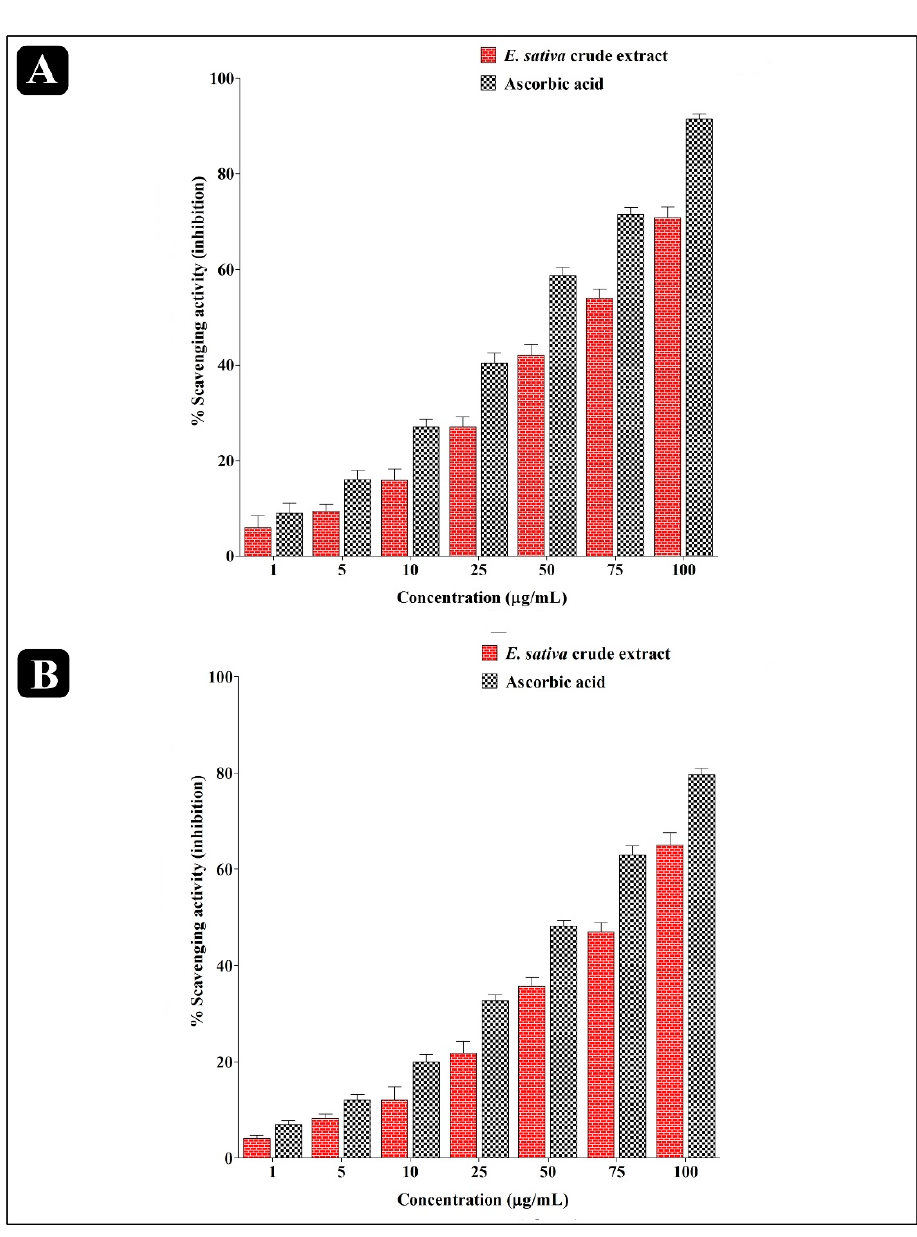
Figure 4. Antioxidant activity of E. sativa crude extract against ( A ) DPPH molecules and ( B ) H 2 O 2 molecules. The activity was carried out in triplicate and the data represent the mean ± SD.